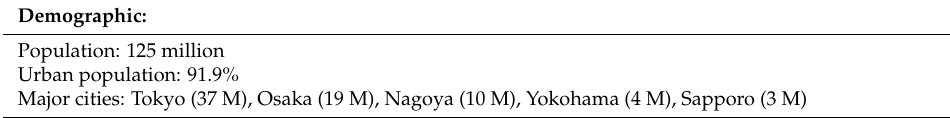
Table 1. Profile of Japan: